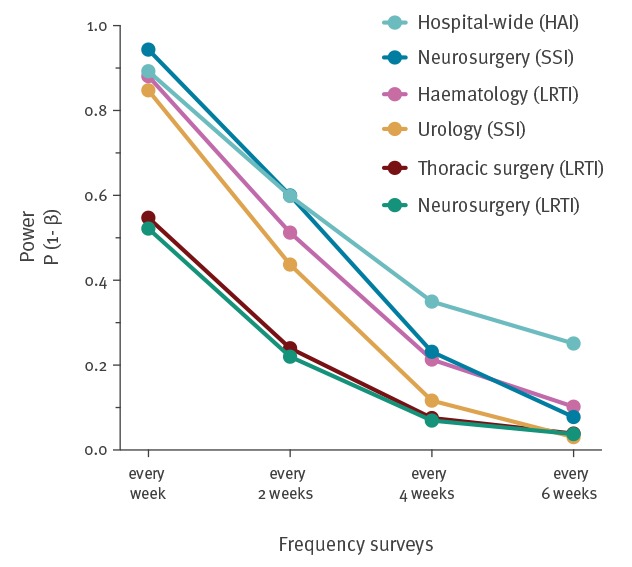
Effect of survey frequency on its power to detect significant trends in the occurrence of indicated types of hospital-acquired infections at department level, Netherlands, 2013–2014 (n = 51,900)